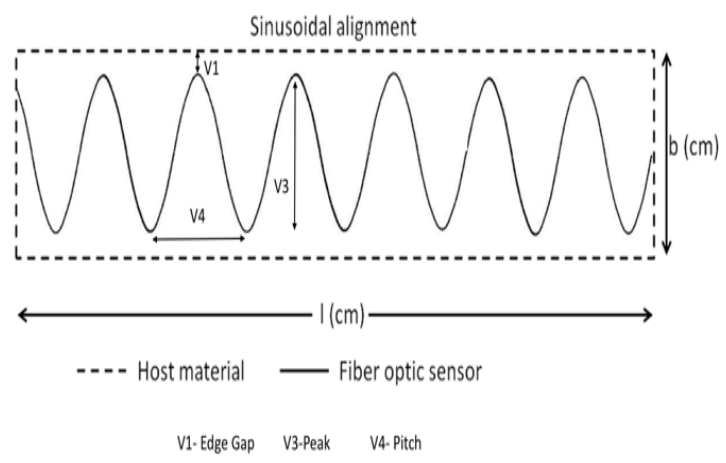
Figure 4. Sinusoidal FOS Alignment Showing 3 variables to optimise. Figure 4 . Sinusoidal FOS Alignment Showing 3 variables to optimise. Figure 4 . Sinusoidal FOS Alignment Showing 3 variables to optimise.